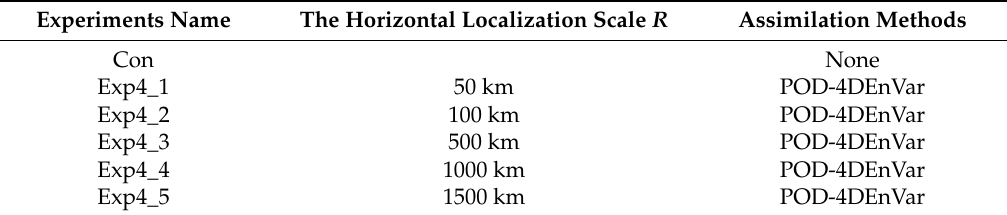
Table 8. Experimental design for horizontal localization scale.